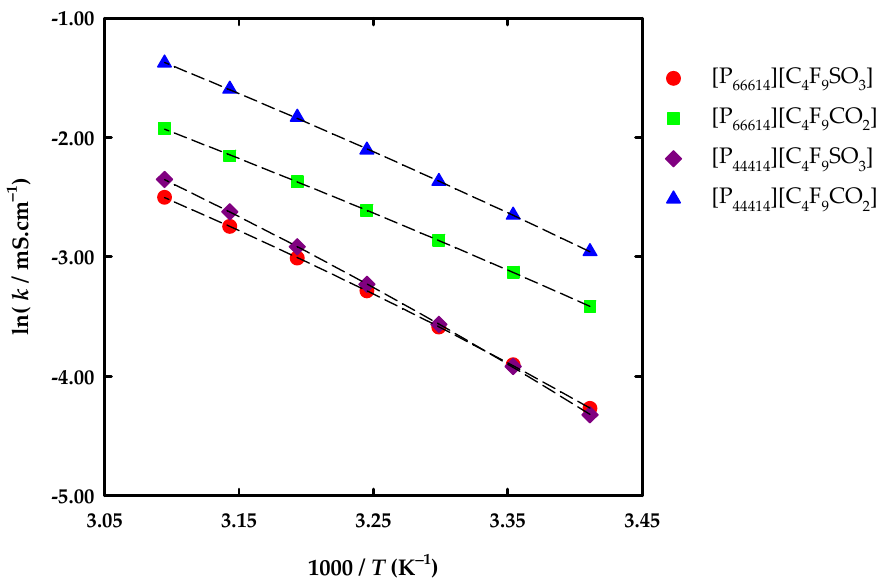
Figure 5. Arrhenius plots of experimental conductivity and the corresponding fitted curves for the synthesized fluorinated ionic liquids.